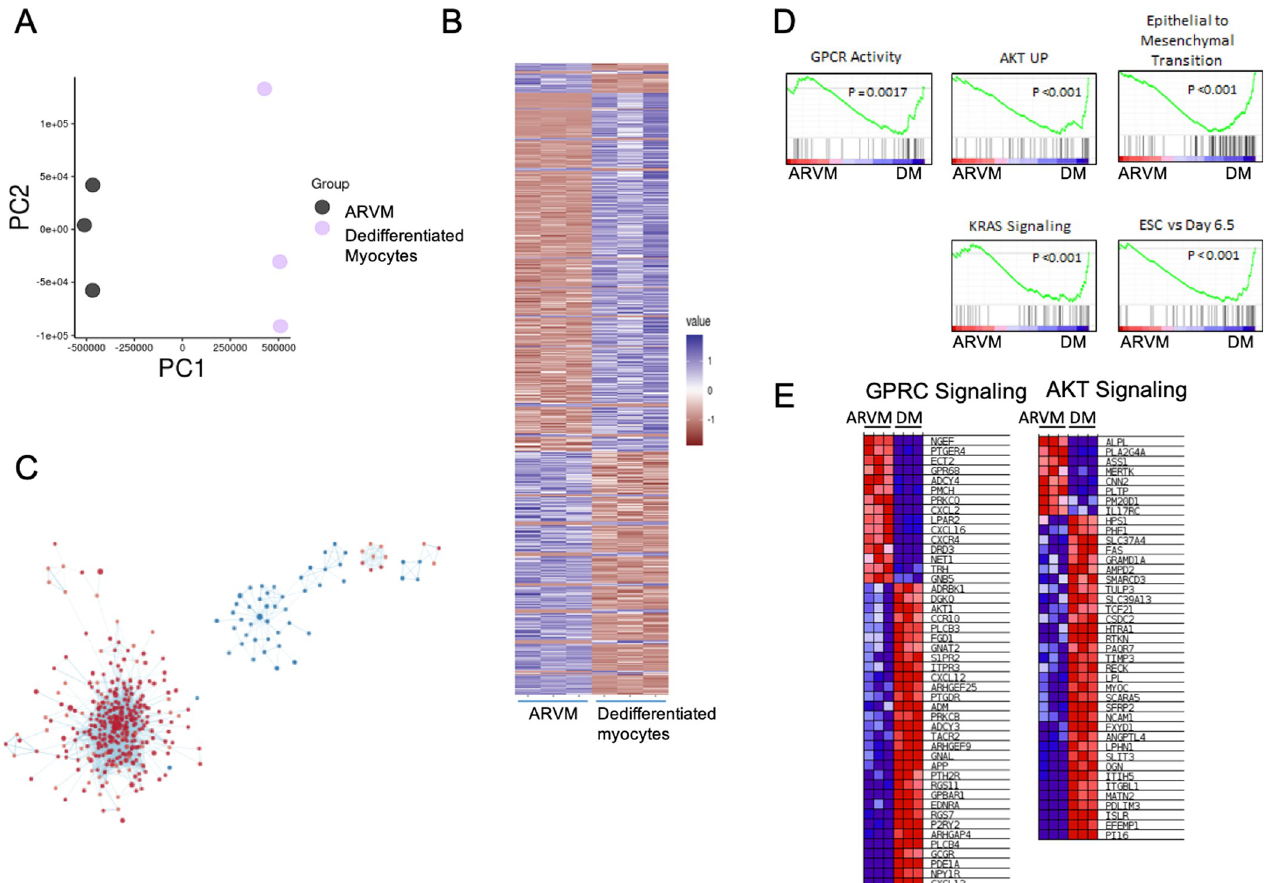
Fig 6. Dedifferentiated adult ventricular myocyte (ARVM) RNAseq. A) PCA plot of ARVMs treated with and without conditioned media from PH fibroblasts. B) Heatmap of gene expression comparing control, freshly isolated ARVMs to ARVMs treated with PH Fibroblast conditioned media. Genes with a significant difference of < 0.05 were selected. Expression values were scaled from -1 to 1, similarity was calculated using an euclidean distance and clustered using a centroid linkage k-means method. C) Network of transcriptional changes. We displayed differentially enriched pathways from GSEA as enrichment networks in which each node is a pathway, and each link between nodes is a common gene. The size of the nodes indicates the number of genes found in our data that are in the pathway. Red coloring indicates pathways enriched in the ARVM PH group, whereas blue indicates pathways enriched in the control ARVM group. D) Select enrichment plots highlighting the enriched pathways identified by GSEA. E) Representative heat maps for G-protein coupled receptor, downstream signaling pathways (GPCR signaling) and AKT signaling pathways showing the genes responsible for enrichment.